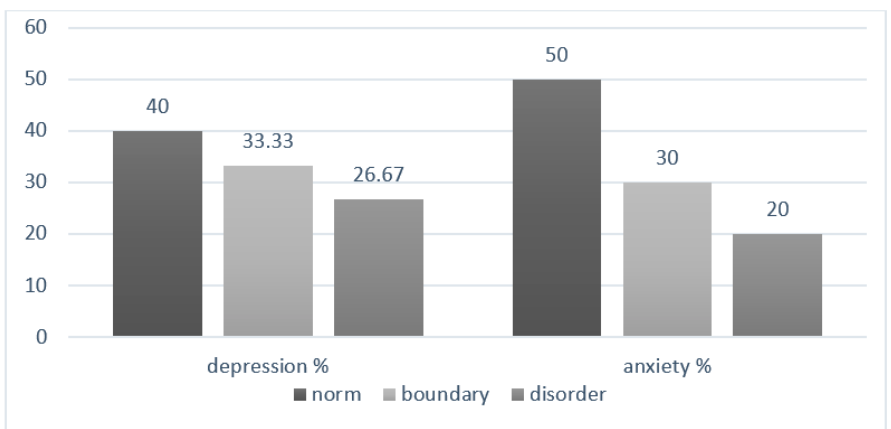
Figure 1. Qualitative assessment of anxiety and depression—Study II.